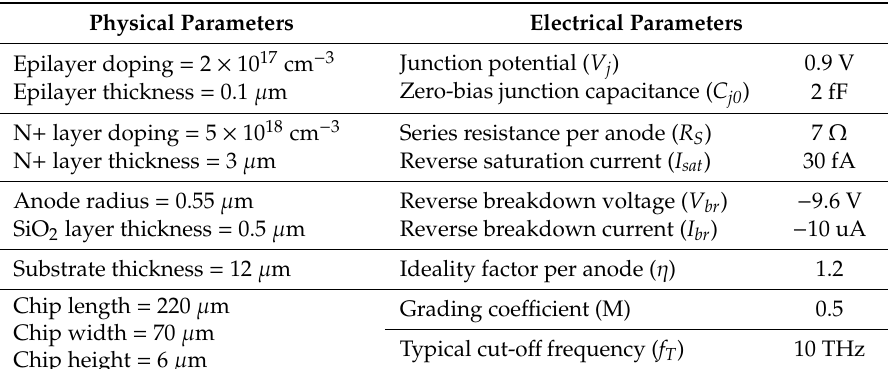
Table 2. Physical and electrical diode parameters of the 0.34 THz